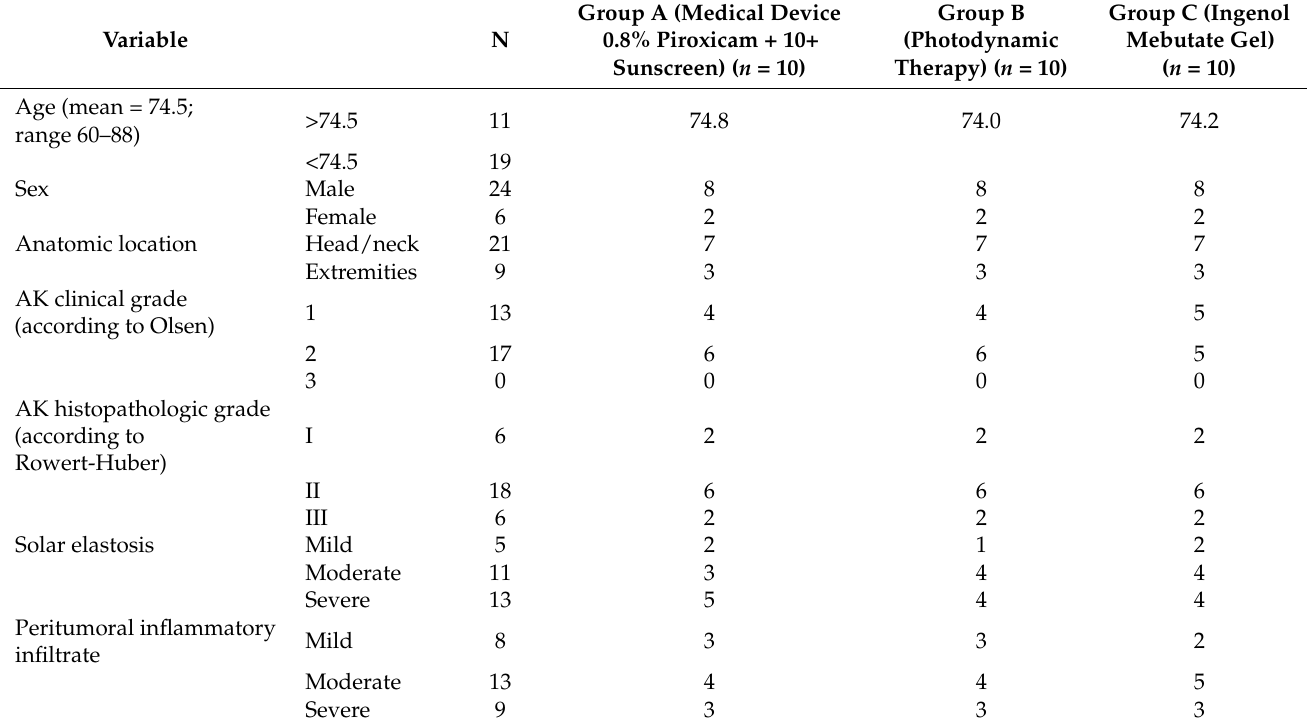
Table 1. Demographic and clinico-pathological data of enrolled patients before treatments ( n =